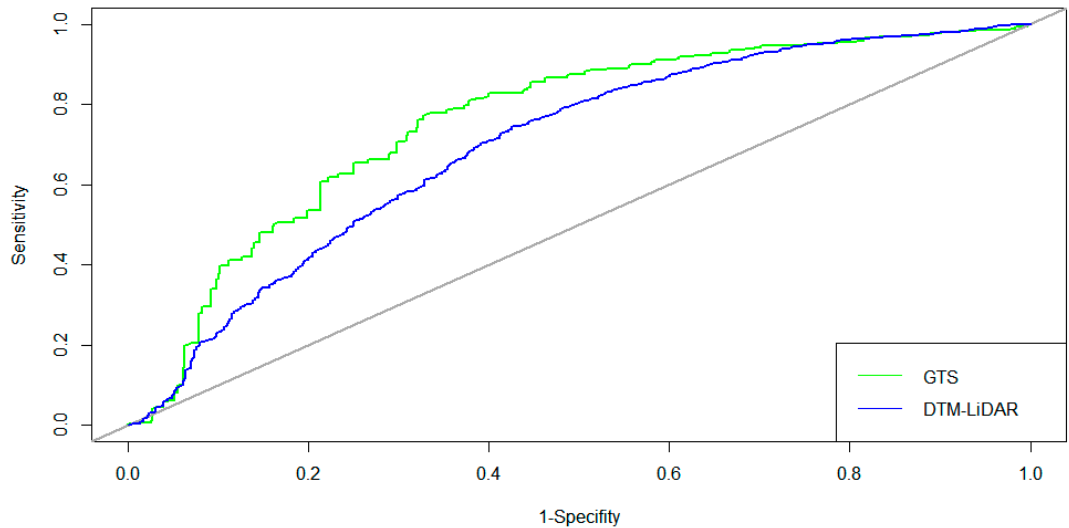
Figure 8. Relative Operating Characteristics (ROC) curve for the landslide prediction map based on the model.